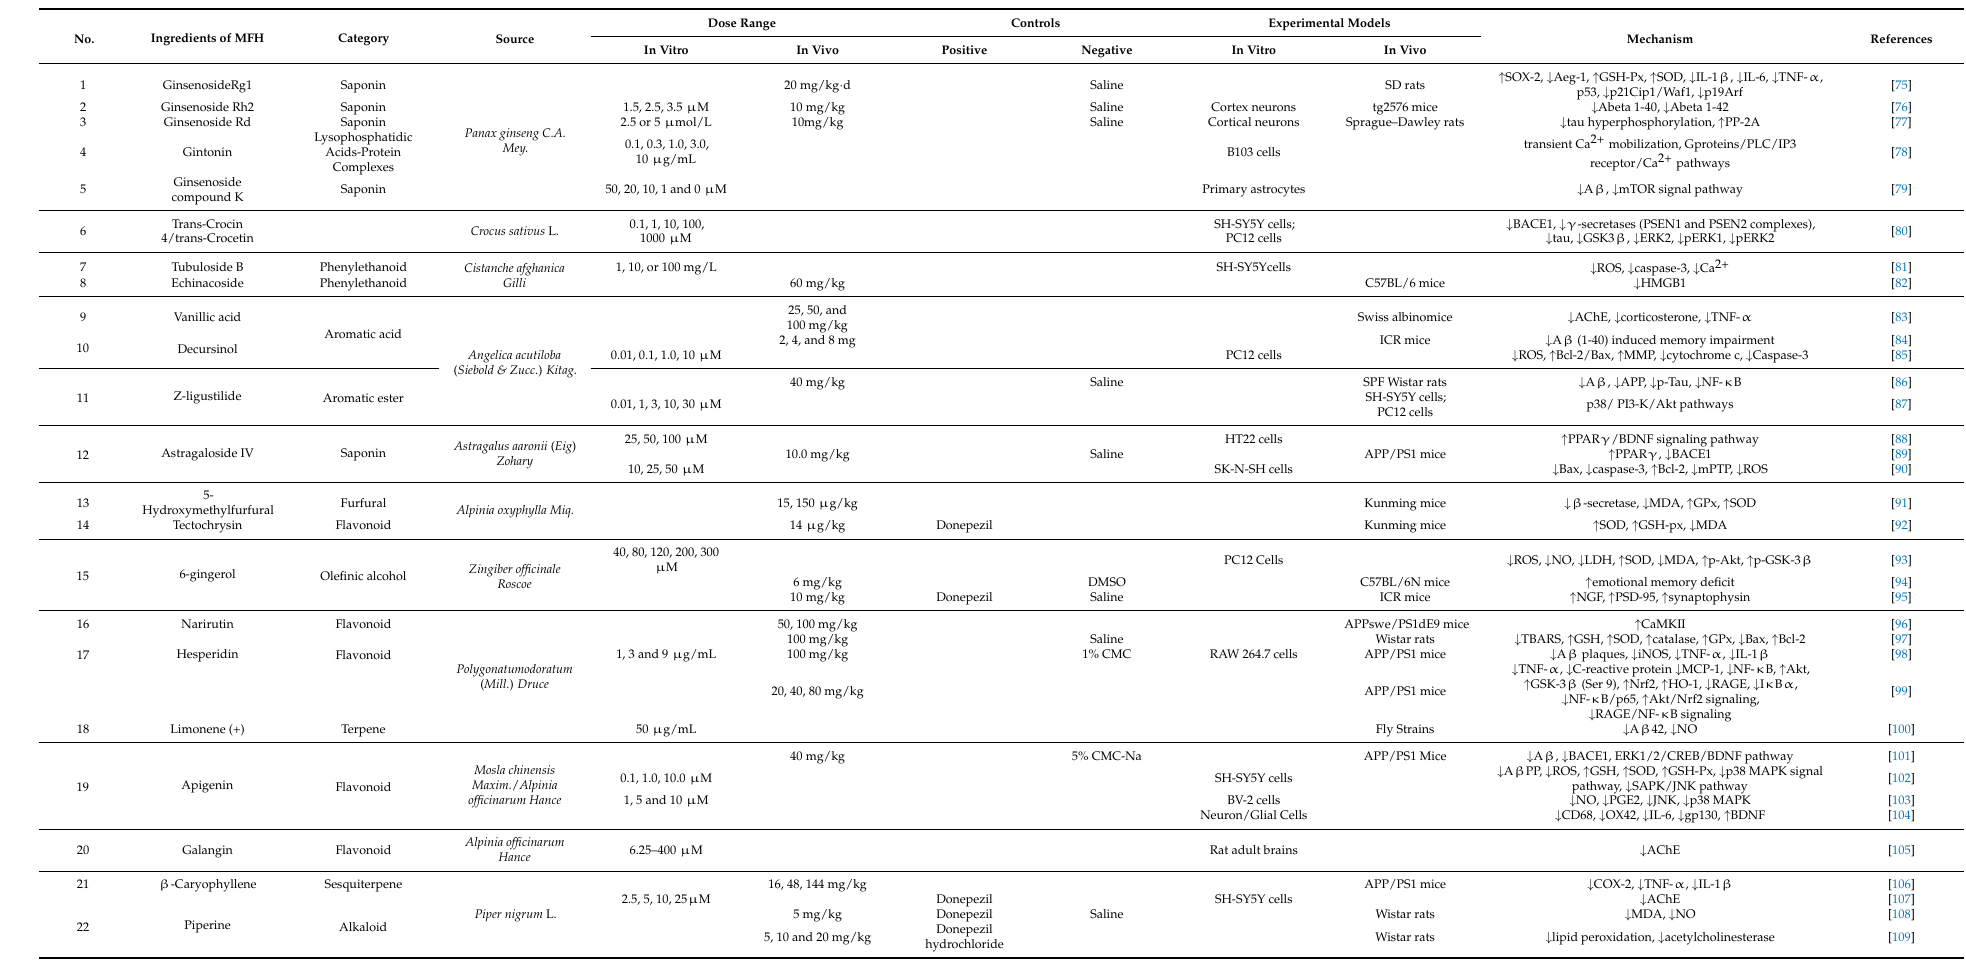
Table 5. Active ingredients from MFH on the role and mechanism of Alzheimer’s